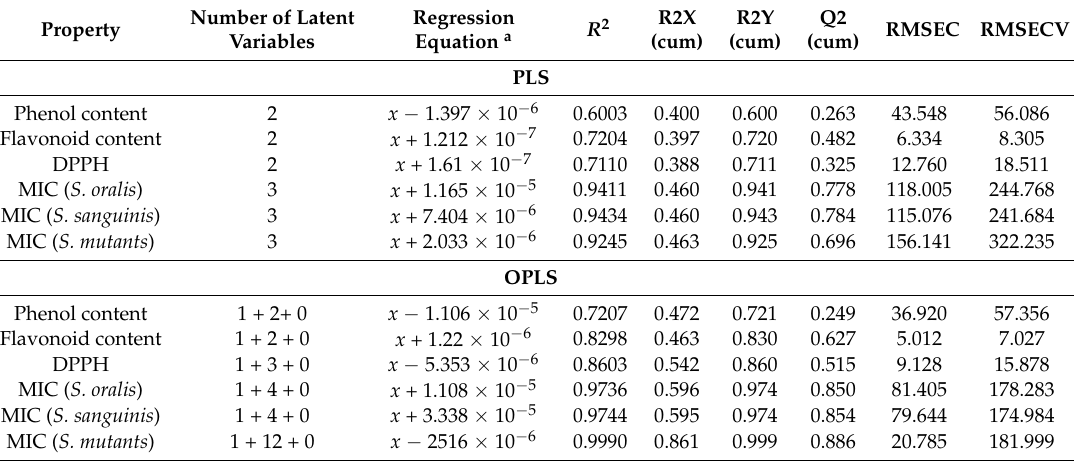
Table 2. Results of the PLS and OPLS modeling of propolis